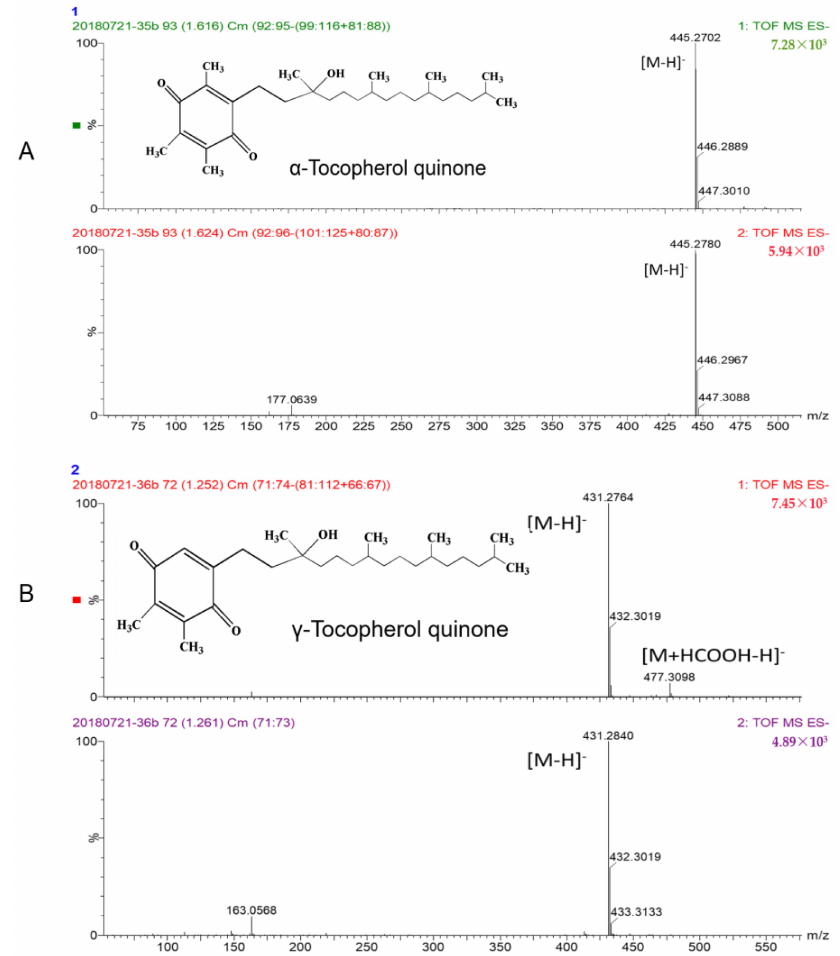
Figure 8. MS spectrum analysis of α -TQ ( A ) and γ -TQ ( B